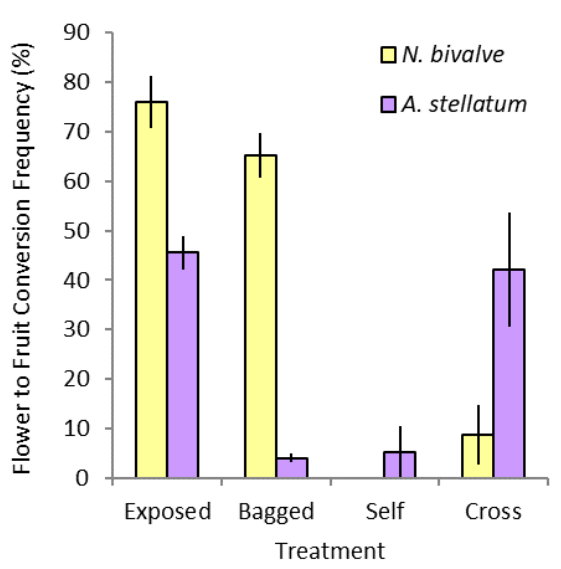
F IGURE 10. Mean percentage of fruit per flower per umbel of N. bivalve (N = 20-23) and A. stellatum (N = 19-37). Error bars are standard error of the mean.